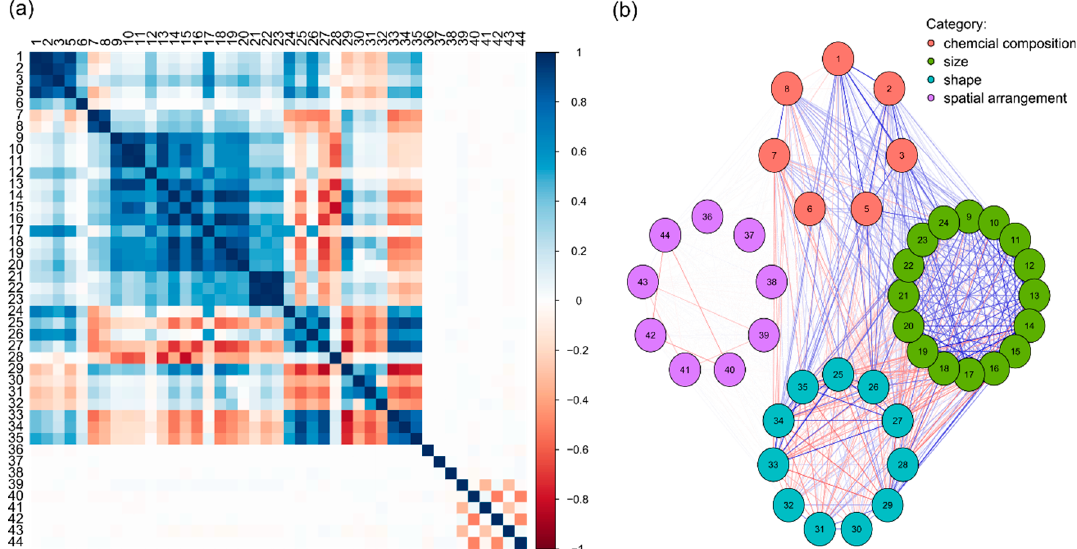
Figure 5. ( a ) Heatmap of the correlation matrix between the variables. The colour designates the value of the correlation coefficient between particular variables; ( b ) A graph showing correlation between variables in a form of network. The colour of the nets corresponds to this presented in Figure 5a and designates the correlation coefficient. The variables are grouped regarding their categorical subdivision. Numbers (1–44) correspond to the names of variables (see Appendix C, Table A1).